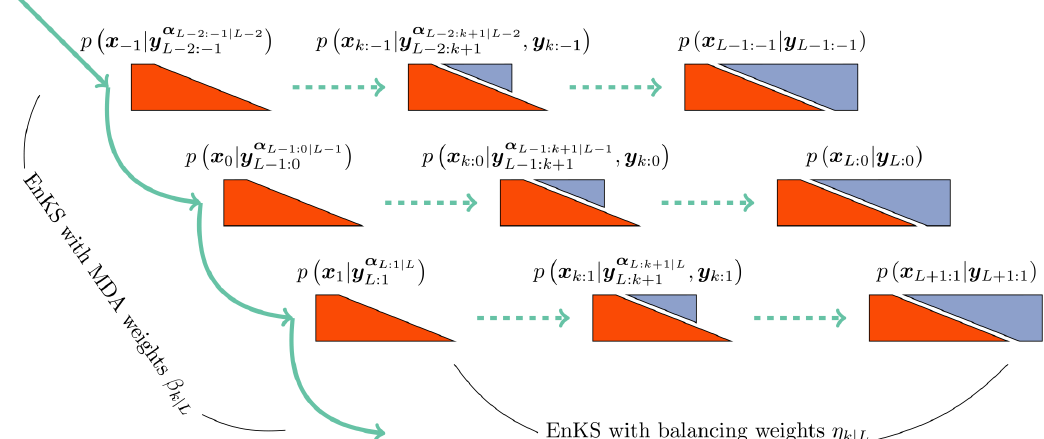
Figure 5. A schematic of the two stages of the SIEnKS MDA cycle. The DAW of the SIEnKS moves forward in time, from top to bottom, where the EnKS stage using MDA weights pushes the MDA conditional density, on the far left, forward in time. The middle layer represents the indexing of the stationary DAW, while the top layer represents a DAW one cycle back in time, and the bottom layer represents a DAW one cycle forward in time. The balancing density is sampled sequentially and recursively with an EnKS stage, using the balancing weights and moving from left to right in each cycle. For the current DAW, the middle balancing density has fully assimilated observations y k : 0 and α L − 1 : k + 1 | L − 1 has partially assimilated observations y . The EnKS stage with balancing weights completes when sampling the joint posterior, L : k + 1 and the EnKS stage with MDA weights begins